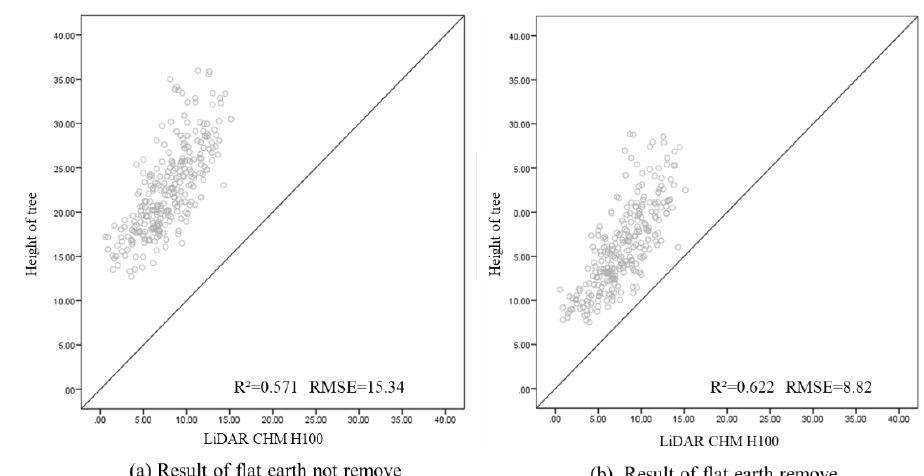
Figure 11. Influence of flat earth on forest height estimation by SINC